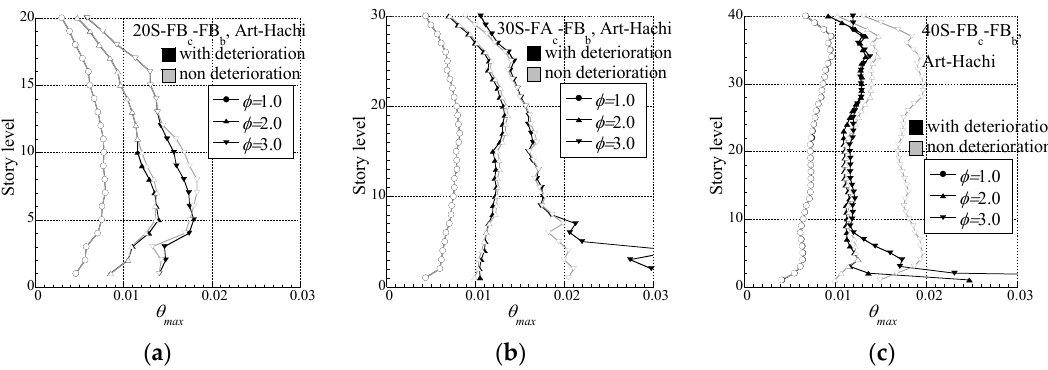
Figure 10. Distribution of maximum story drift angle of high ‐ rise SMRF models with thin ‐ walled members. ( a ) 20S ‐ FB c ‐ FB b ; ( b ) 30S ‐ FB c ‐ FB b ; ( c ) 40S ‐ FB c ‐ FB b .